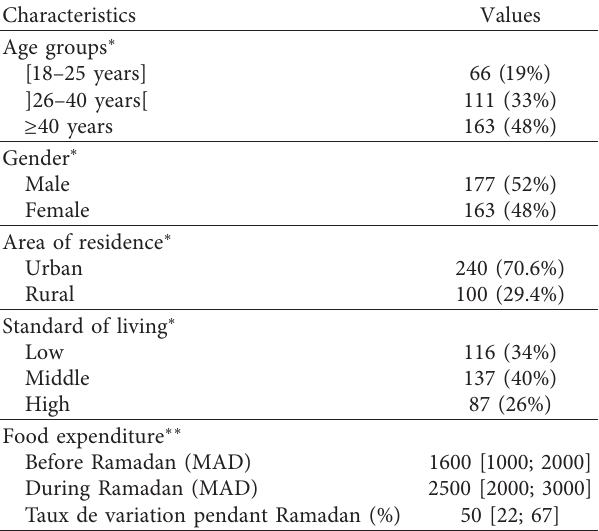
Table 1: Sociodemographic and socioeconomic characteristics ( n �